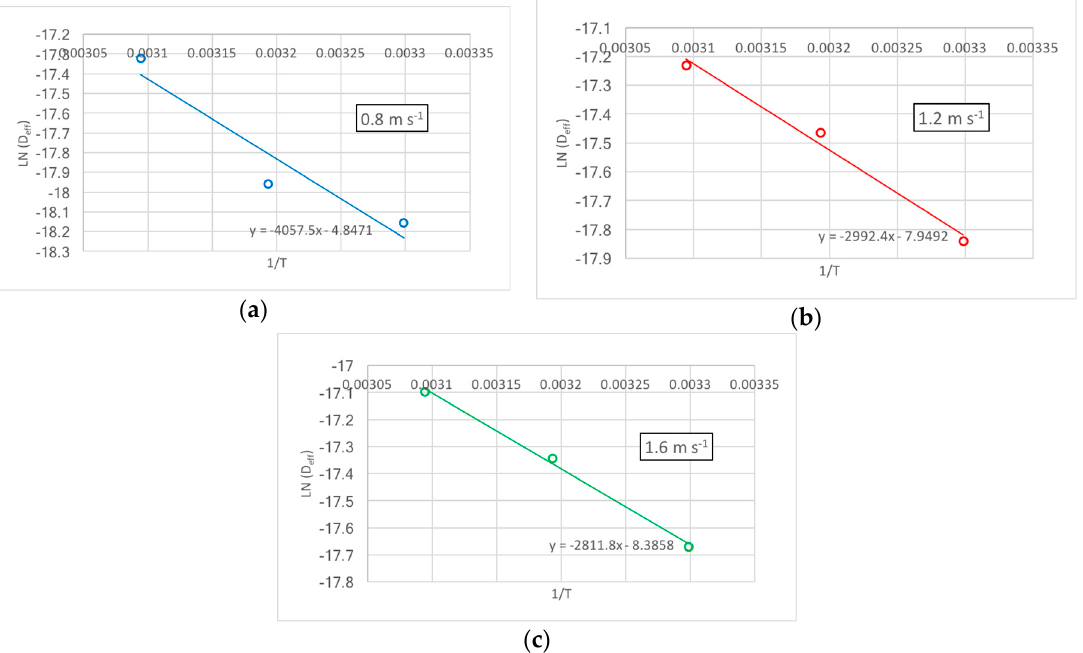
Figure 3. LN ( D eff ) vs 1/ T (K − 1 ) values. ( a ): for 0.8 m s − 1 . ( b ): for 1.2 m s − 1 . ( c ): for 1.6 m s − 1